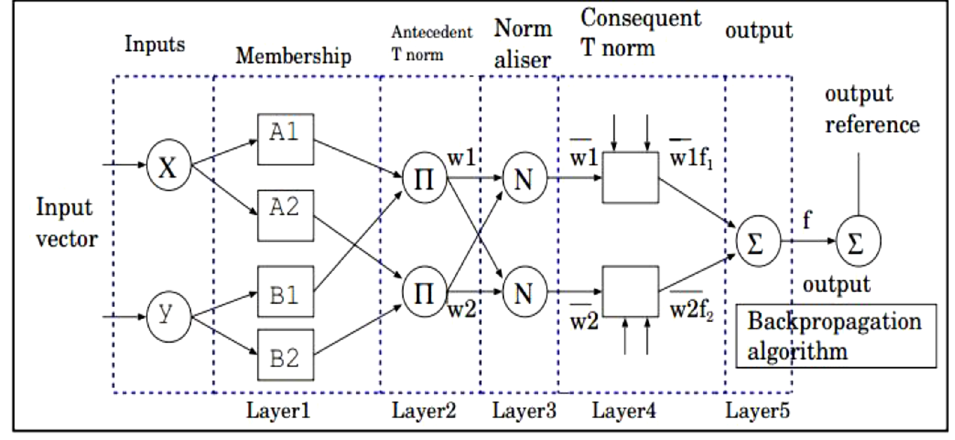
Figure 4. Architecture of